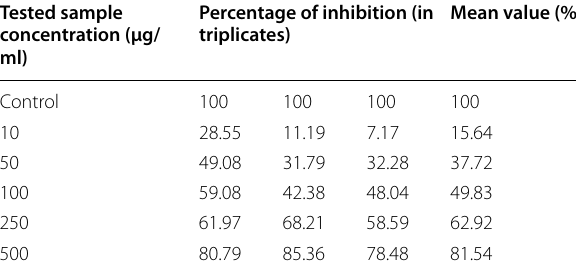
Table 5 Cholinesterase activity Tested sample OD value at 410 nm (in concentration (µg/ml) triplicates)